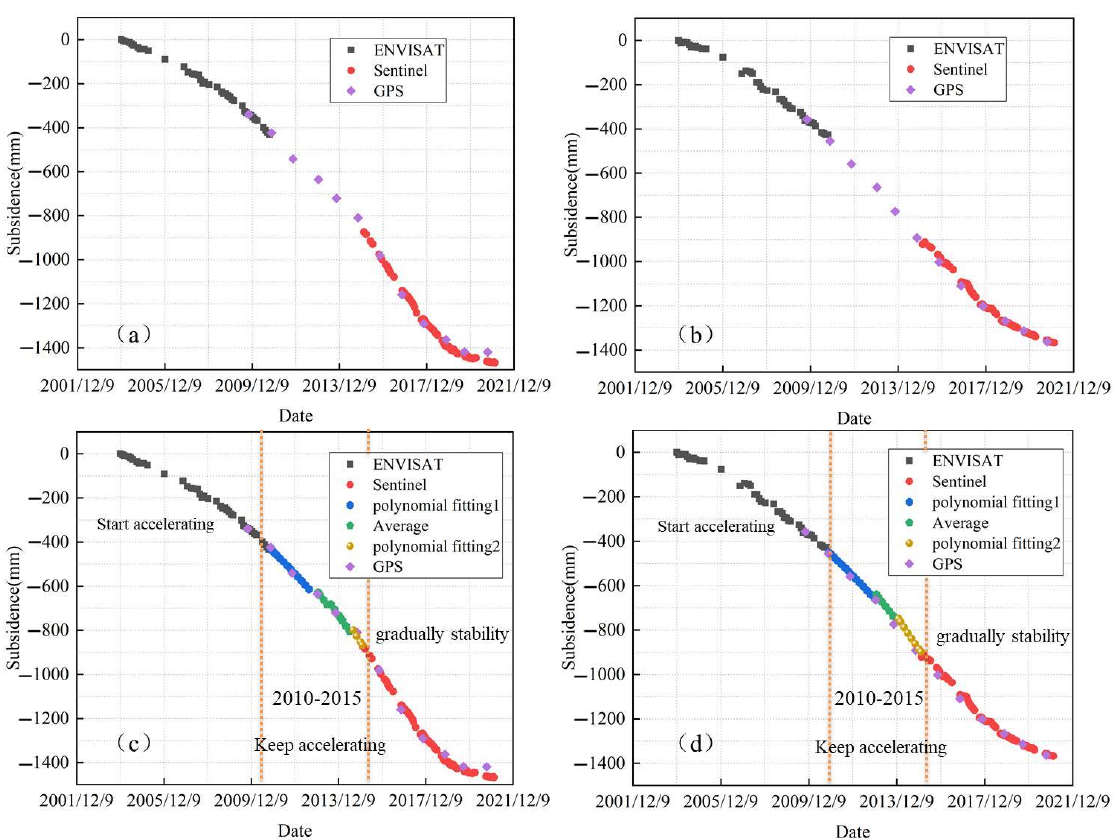
Figure 8. Comparison of the corrected time series settlement with GPS observation results: ( a ) and ( b ) are the corrected results of time series deformation at P3 station and P5 station, respectively. ( c ) and ( d ) are the supplemented results at P3 station and P5 station during 2010–2015.